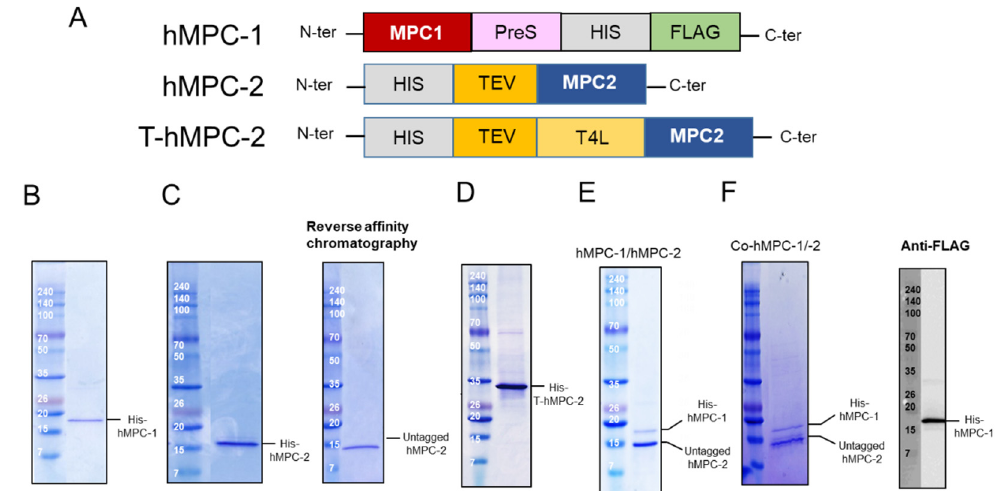
Figure 1. Construct design and purification of human mitochondrial pyruvate carriers (hMPCs). ( A ) Schematic diagram of designed hMPC constructs. ( B – D ) Purification profiles of ( B ) His-hMPC-1, ( C ) His-hMPC-2 (left) and untagged hMPC-2 (right), and ( D ) His-T-hMPC-2. The N-terminal tags were removed from hMPC-2 by Tobacco Etch Virus (TEV). Un-tagged hMPC-2 (14.3 kDa) was isolated after reversed a ffi nity column. The recombinant proteins were visualized by Coomassie blue staining in SDS-PAGE after metal a ffi nity purification. ( E ) His-hMPC-1 (15.9 kDa) and untagged hMPC-2 (14.3 kDa) after the FLAG-resin column was co-eluted and confirmed by SDS-PAGE. ( F ) The co-expressed proteins, co-hMPC-1 / -2, were confirmed by Coomassie blue staining in SDS-PAGE after purification. After TEV cleavage reaction, His-hMPC-1 and untagged hMPC-2 was co-eluted in the FLAG-resin column. hMPC-1 was confirmed by anti-FLAG-tag immunoblot analysis.